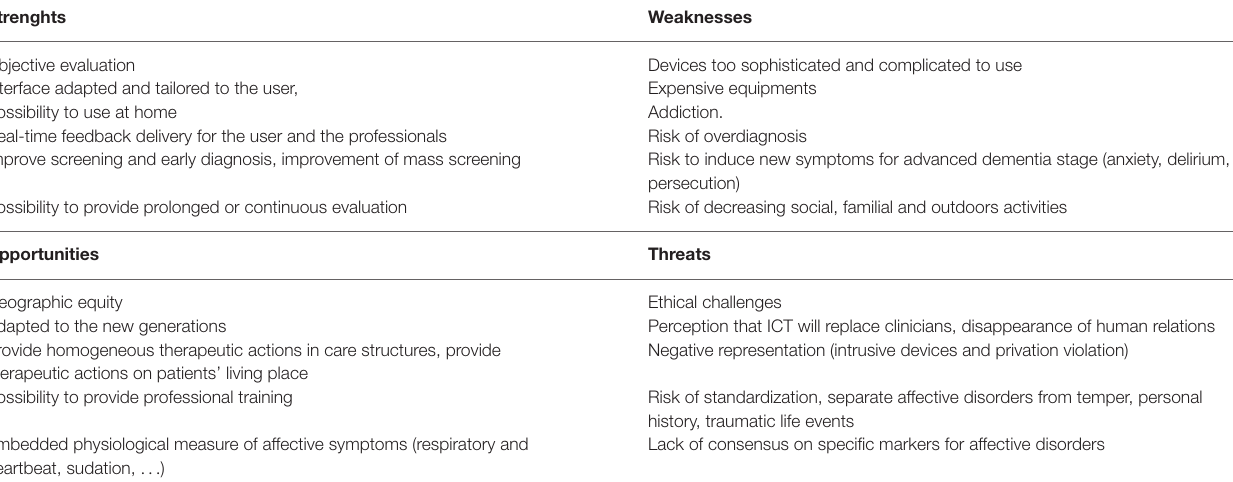
TABLE 1 | Strengths, Weaknesses, Opportunities, and Threats (SWOT).